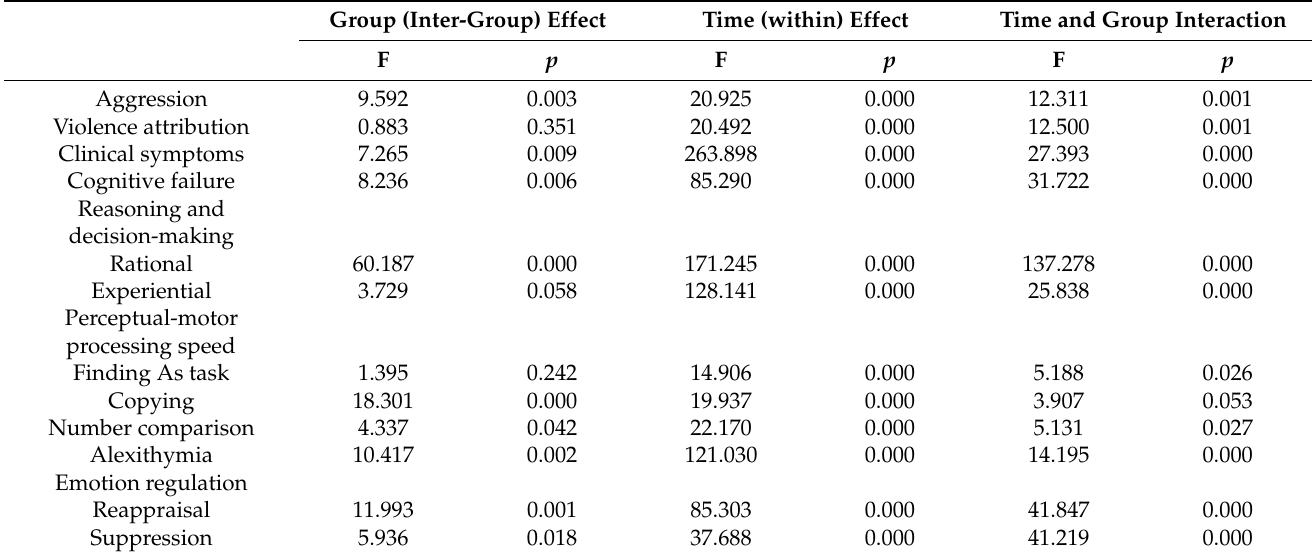
Table 5. Repeated-measures effects of the Integrated Cognitive Based Violence Intervention Program on study